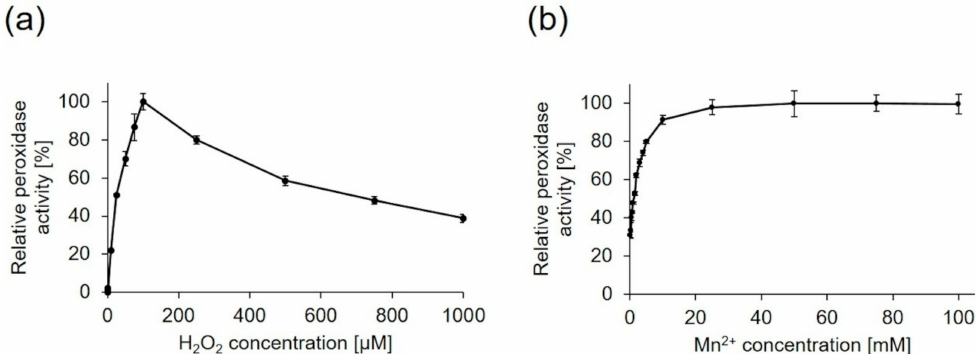
Figure 6. E ff ect of hydrogen peroxide ( a ) and Mn 2 + concentration ( b ) on the activity of PsaPOX. Relative peroxidase activity [%] was defined as the percentage of activity detected with respect to the highest activity obtained in each experiment. Values are the average of triplicate experiments with standard deviations shown as error bars.